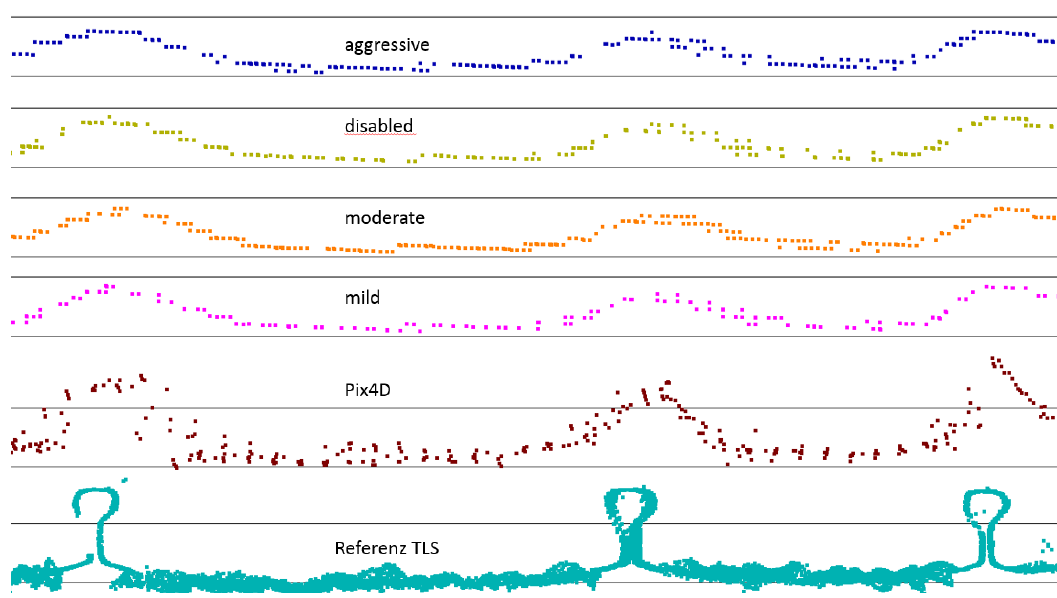
Figure 9. Profiles created with PhotoScan as shown in Figure 8, but using different filter factors compared to TLS